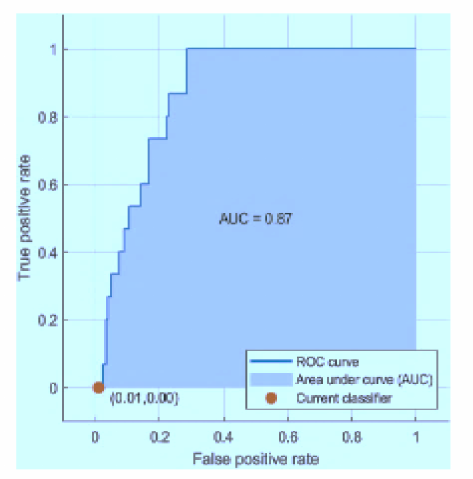
Figure 15. Receiver operating characteristic (ROC) curve for the ensemble RUSBoosted